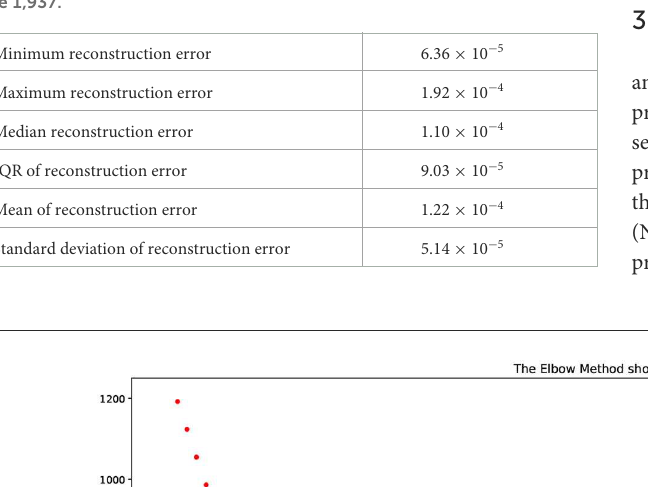
TABLE 2 Summary statistics of the reconstruction error when lower dimension d = 35 over ten random replications of the training data set of size 1,937.